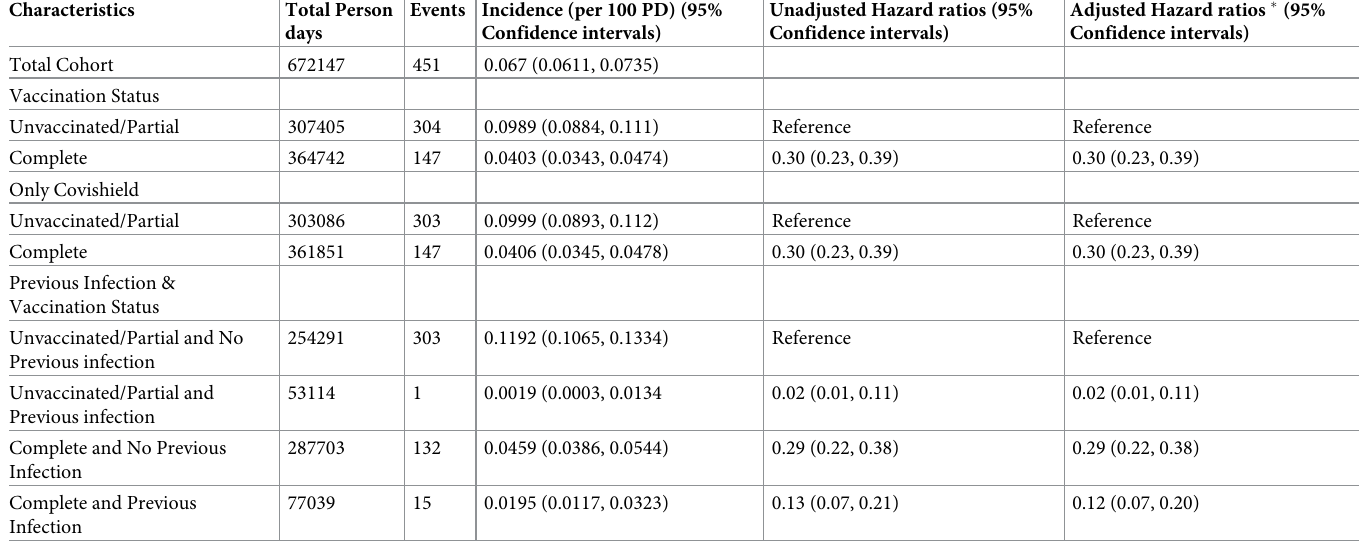
Table 2. Table showing the incidence rate of COVID-19 infections and hazard ratios (with 95% confidence intervals) in a cohort of 2762 health care personnel in a tertiary care centre, Mumbai, India.